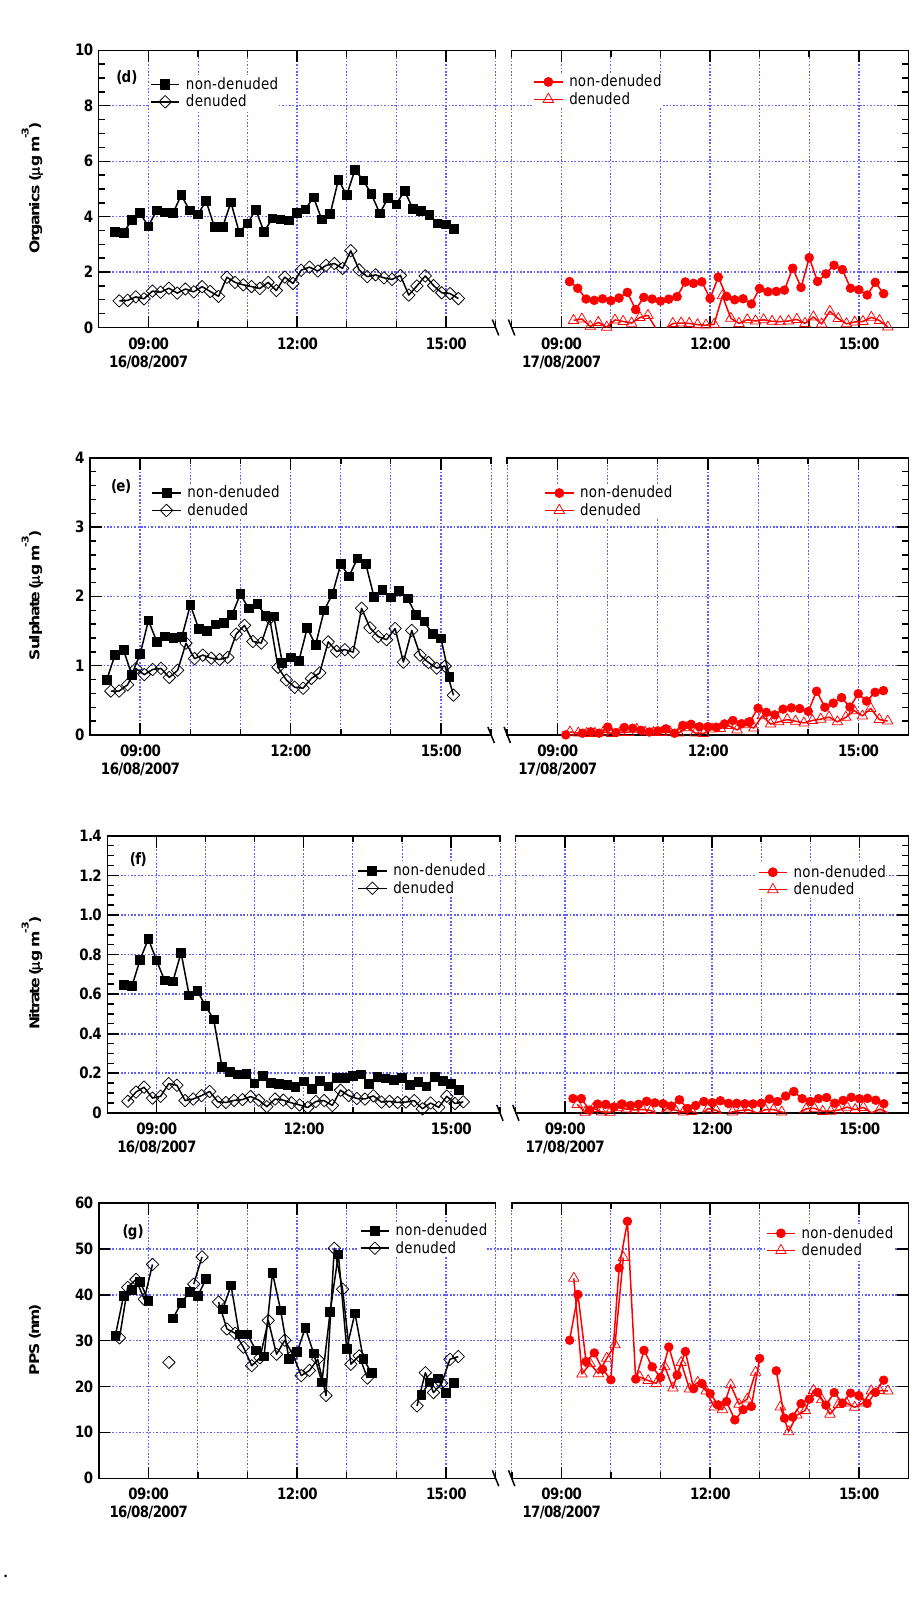
Figure 3: Time series of (a) black carbon mass concentration, (b) non-refractory mass to 1347 BC mass ratio, (c) specific absorption cross-section, (d) organic matter mass 1348 concentration, (e) sulphate mass concentration, (f) nitrate mass concentration, and (g) 1349 PPS during the two days of the thermodenuder experiment.1350